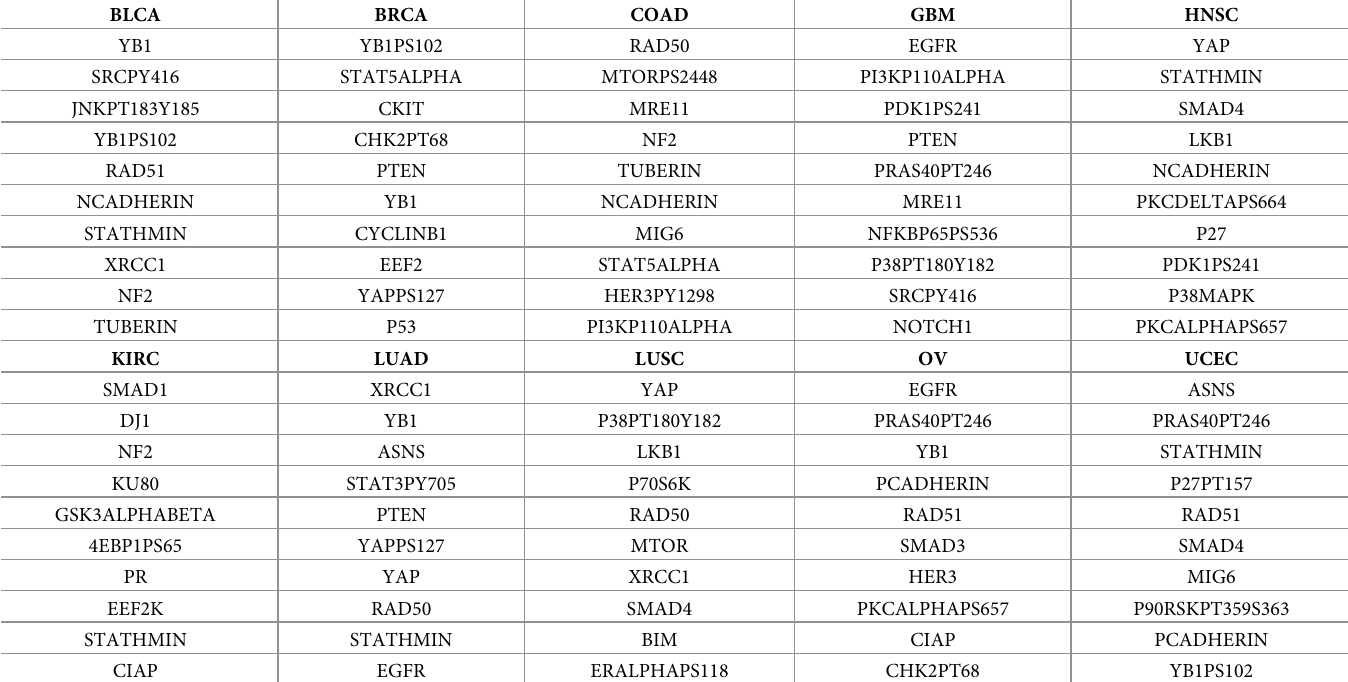
Table 3. Top-10 rank differentiated features in each cancer with